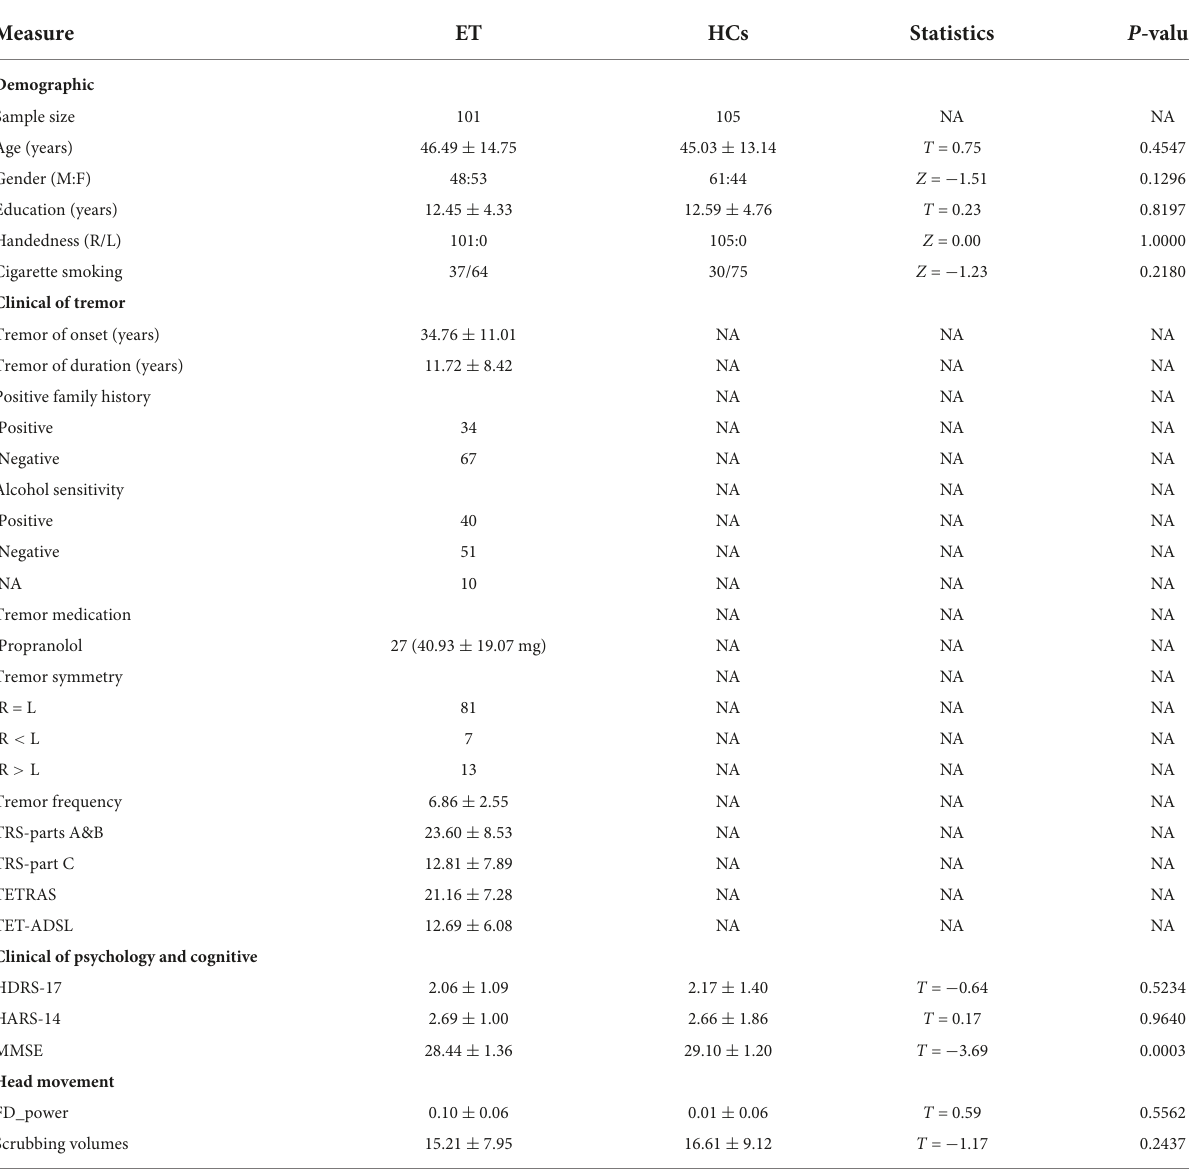
TABLE 1 Demographic and clinical features of ET and